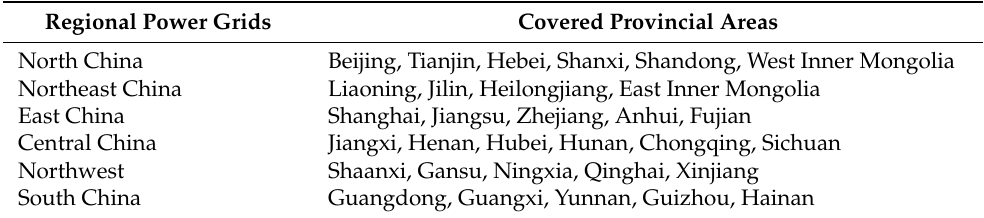
Table 1. Geographical boundaries of six regional power grids within China. Regional Power Grids Covered Provincial Areas